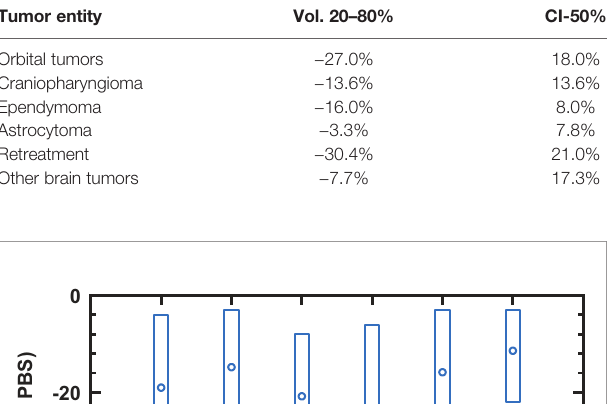
TABLE 4 | Percentage difference in D V 20-80% and CI 50% for PBS-with-aperture plans compared with uncollimated PBS plans. Tumor entity